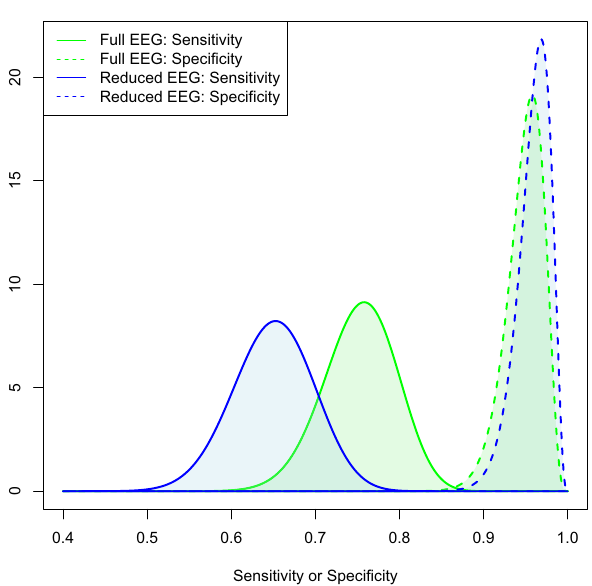
Figure 2. Posterior distributions for the sensitivity and the specificity of both EEG montages. Similar to the use of confidence intervals this plot shows the estimations for the sensitivities and specificities. The lower, and wider, curves for the sensitivities signify that, given the observed data (i.e. the EEG classifications), there is still a relevant degree of uncertainty regarding the true sensitivities.